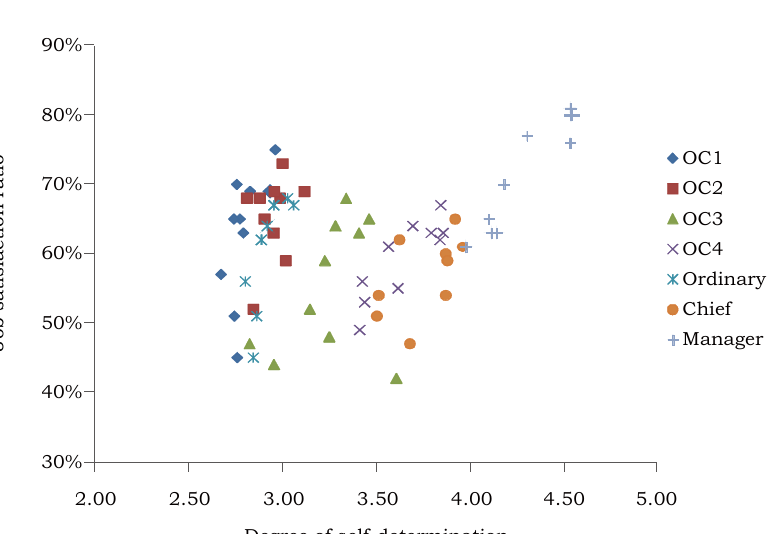
Figure 1. Annual transitions in degree of self-determination and job satisfaction ratio by occupational category/rank